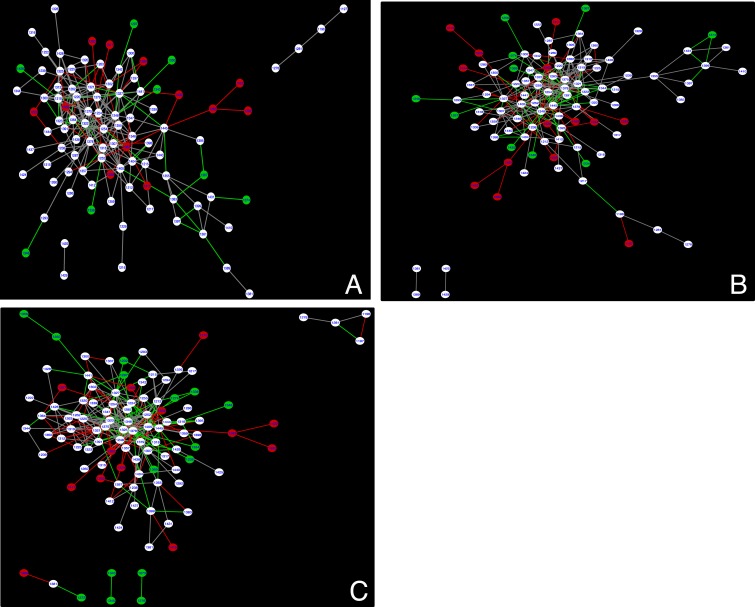
ELSC analysis of Wildtype MSA subsets.Overlay of cytoscape maps for Wildtype (5,032) and (A) 2000, (B) 1000, and (C) 500 sequence MSA subsets, respectively. The original Wildtype MSA is colored red and the subset is colored green with overlapping nodes and edges colored white and grey, respectively. Maps are representative of analyses that were done in triplicate.